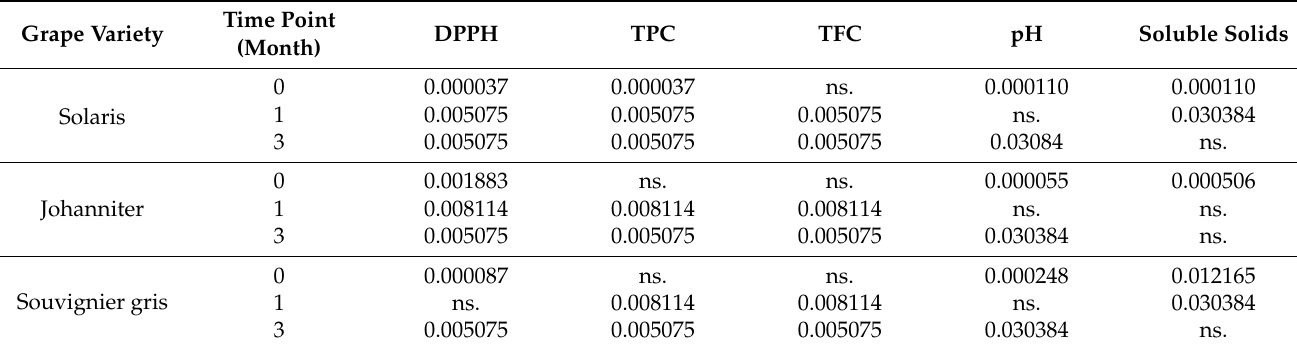
Table 6. The p -values of the Kruskal–Wallis test for samples made with (variant B) vs. without added sugar (variant A) during storage at a room temperature.